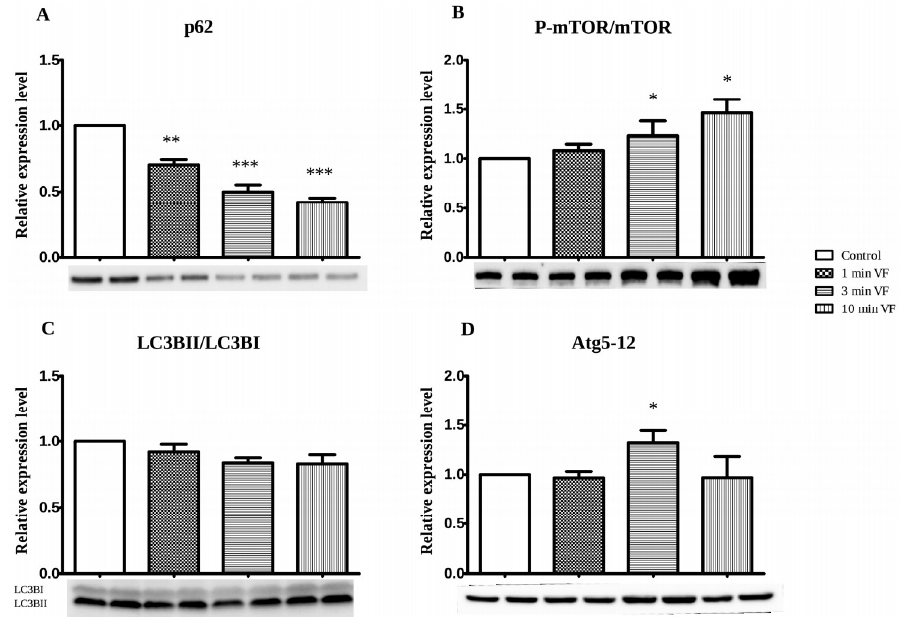
Figure 4. Western blot analysis: Effects of electrically induced fibrillation on heart tissue expression of p62 ( A ), mTOR-phosphorylated, and mTOR (mTOR) ( B ) ratio, LC3BII/LC3BI ratio ( C ) and Atg5-12 complex ( D ) proteins. The time-dependent (0, 1, 3, and 10 min) effects of electrically induced VF followed by 120 min perfusion on expressions of selected proteins in isolated working hearts are shown. Hearts were taken from rats and segregated into test groups of 6 hearts per group, and were subjected to 0 (Control), 1, 3, and 10 min periods of electrically-induced VF (20 Hz, 1200 beats = min), respectively, followed by 120 min of aerobic perfusion. Western blot analysis to assess expression of